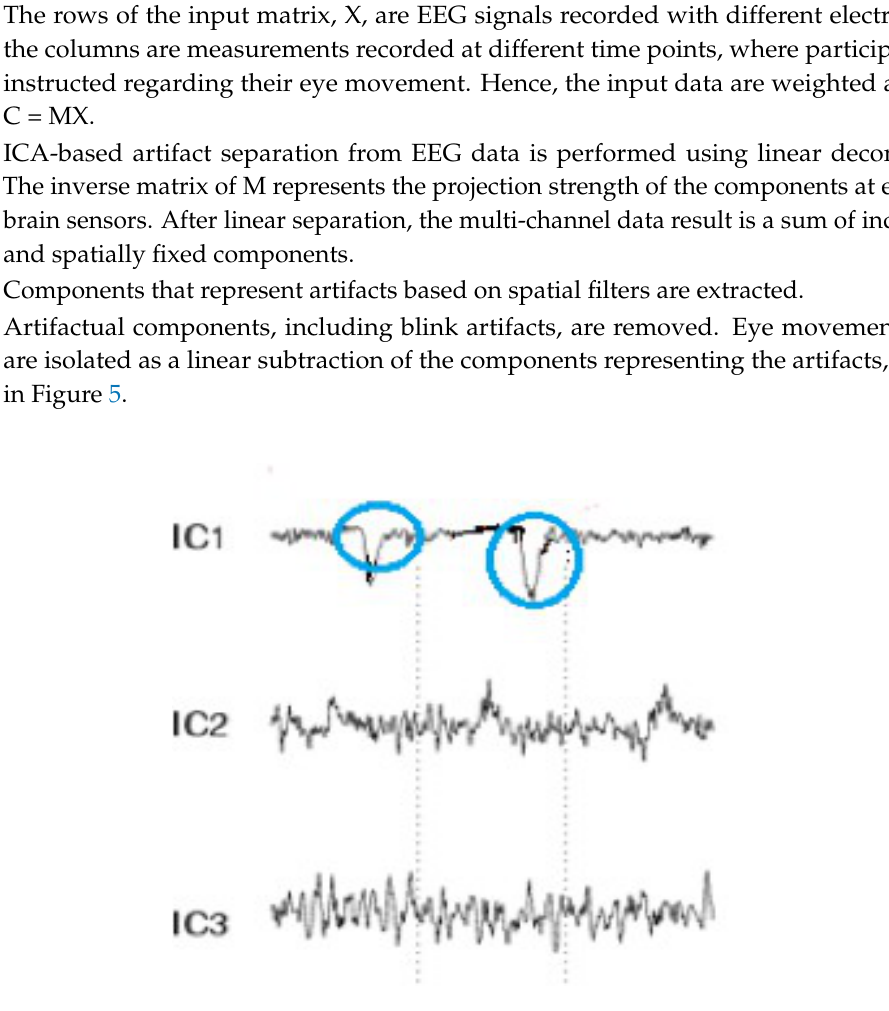
Figure 4. Mixed electroencephalogram/electrooculography (EEG/EOG) data. Note the pulses in the independent components.